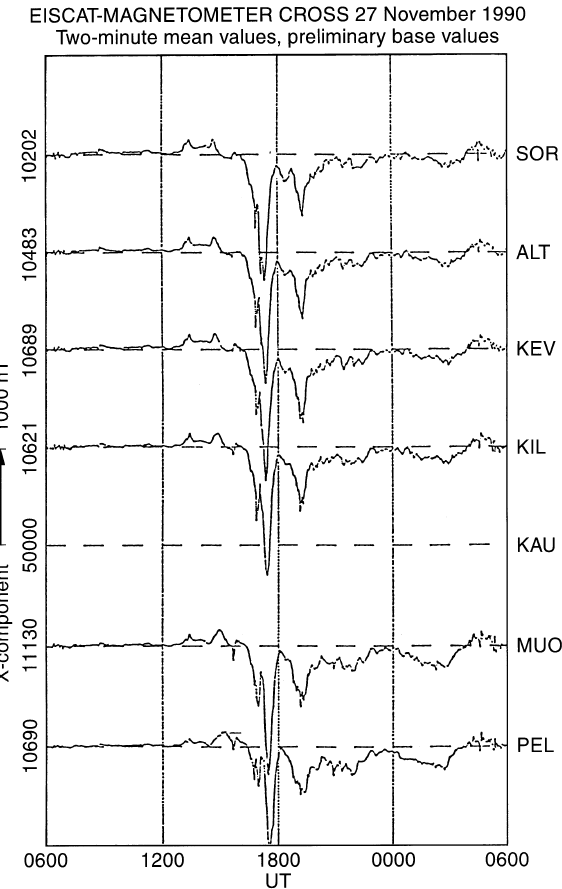
Fig. 6. EISCAT magnetometer data (geographic X -component) on 9– 11 October 1990